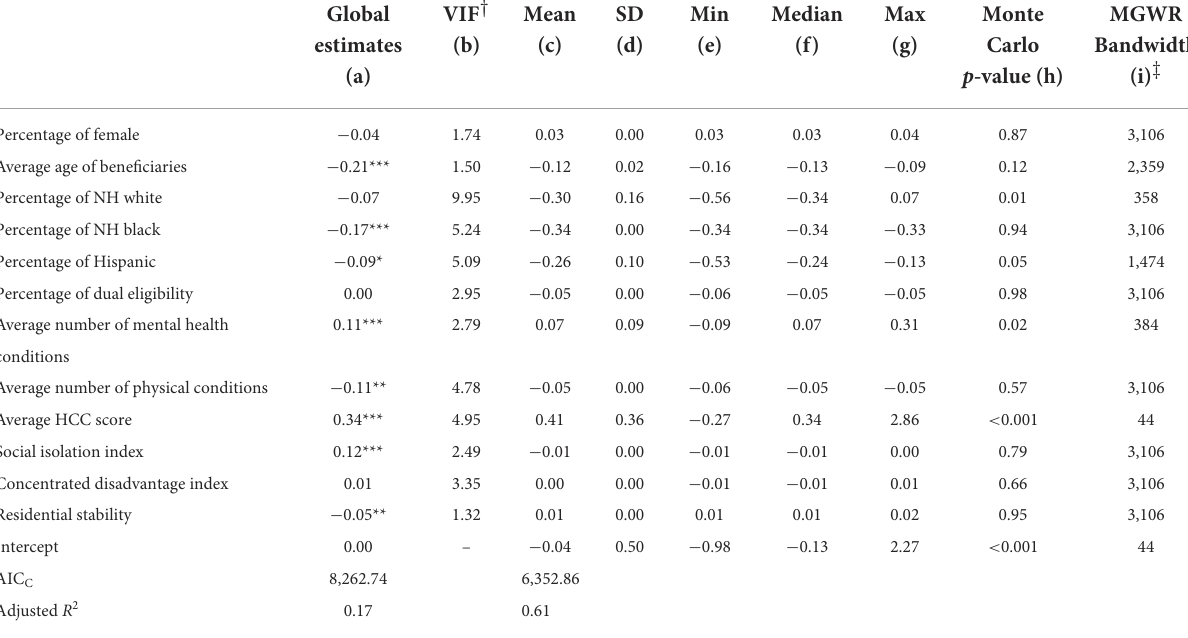
TABLE 2 OLS and MGWR results of opioid use disorder (OUD) rate (per 1,000 older medicare beneficiaries). Global